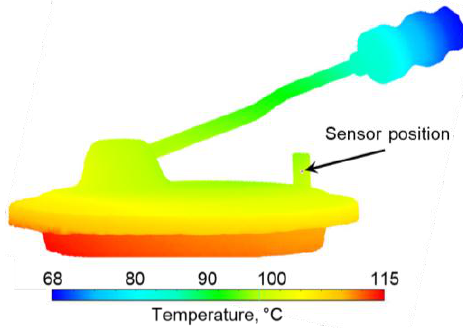
Figure 4. Example of temperature gradients inside the brake fluid volume.